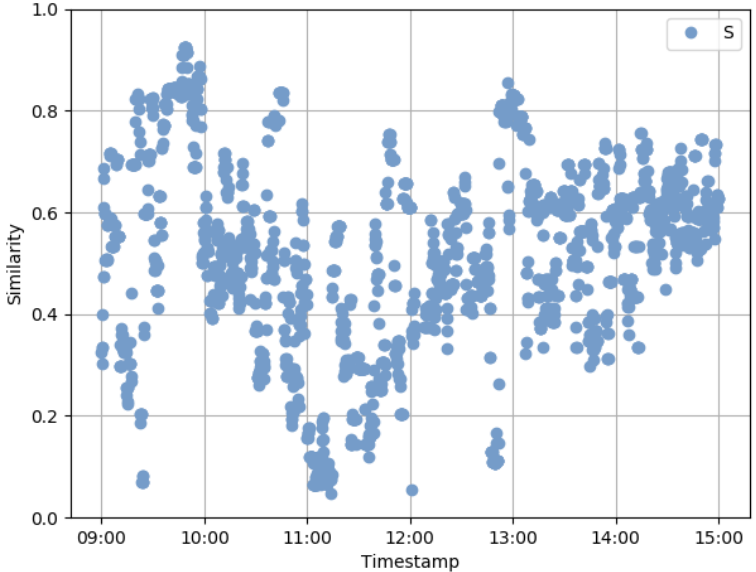
Figure 7. Plot of all calculated average overlaps of real-time against the profile during 6